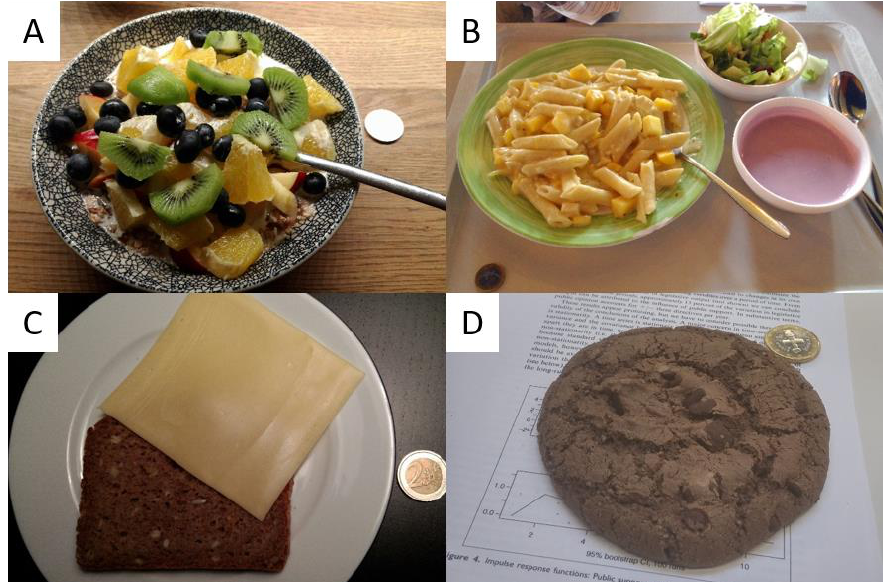
Figure 2. Example food pictures taken by participants. ( A ) Breakfast: 1.5 portions fruit (46%), 1 portion grains and starches (31%), 0.75 portions dairy (23%); ( B ) Lunch: 1 portion vegetables (17%), 1.5 portions grains and starches (25%), 2.5 portions dairy (42%), 1 portion fats (17%); ( C ) Dinner: 1 portion grains and starches (50%), 1 portion dairy (50%); ( D ) Snack: 1 portion sugary extras (100%).